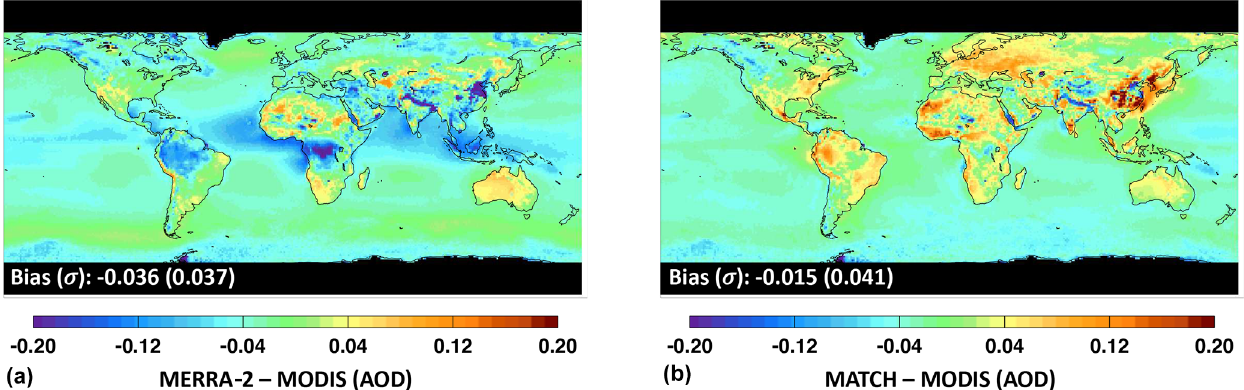
(cid:105) ; see Sect. 2.2 for the definition and an explanation of the Figure 3. Climatological mean aerosol optical depth (AOD, i.e., (cid:104) AOD clr MODIS notation used) difference in (a) MERRA-2 − MODIS and (b) MATCH − MODIS averaged over the period from March 2000 through Febru- ary 2020. MERRA-2 and MATCH daily mean AODs are sampled when the daily mean MODIS AOD from the same 1 ◦ × 1 ◦ grid is available. Sampled daily mean AODs are subsequently averaged. MODIS AODs are averages of the MODIS Dark Target and Deep Blue algorithms from both the Terra (MOD08) and Aqua (MYD08) data